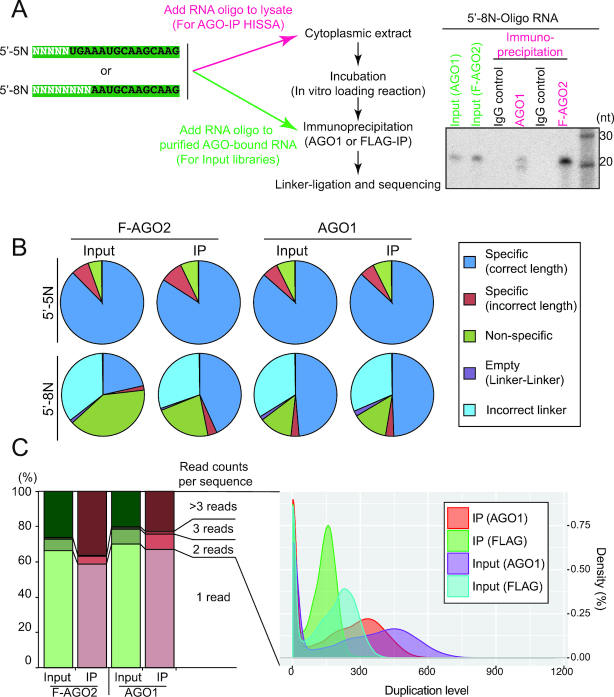
Establishment of a high-throughput in vitro loading assay. (A) Schematic representation of the experimental design. Partially randomized RNA oligos (first 5 or 8 nt for 5′-5N or 5′-8N, respectively) were radiolabeled at the 5′-phosphate, and introduced to the cytoplasmic extract. After the loading reaction, Argonaute complexes were isolated and extracted RNA was subjected to splinted-ligation and library construction. A typical gel picture of co-immunoprecipitated labeled RNA with randomized nucleotides were shown in the right panel. (B) Specificity of HISSA libraries. Reads in the sequenced libraries were grouped under the 5 categories as shown in the legend on the right side of the figure. Reads in the ‘Specific (correct length)’ category were used for further analyses. (C) Analysis of the read duplication level. UMI allowed us to detect the duplication events that occurred during the PCR amplification (see Materials and methods). The stacked columns show that ∼30–40% of reads exhibited evidence for amplification in each library. The right panel shows the distributions of duplication levels of individual sequences. Sequences with more than one read with identical UMI-insert combinations were used for the distribution plot. In some cases, hundreds of reads were derived from a single cDNA molecule.